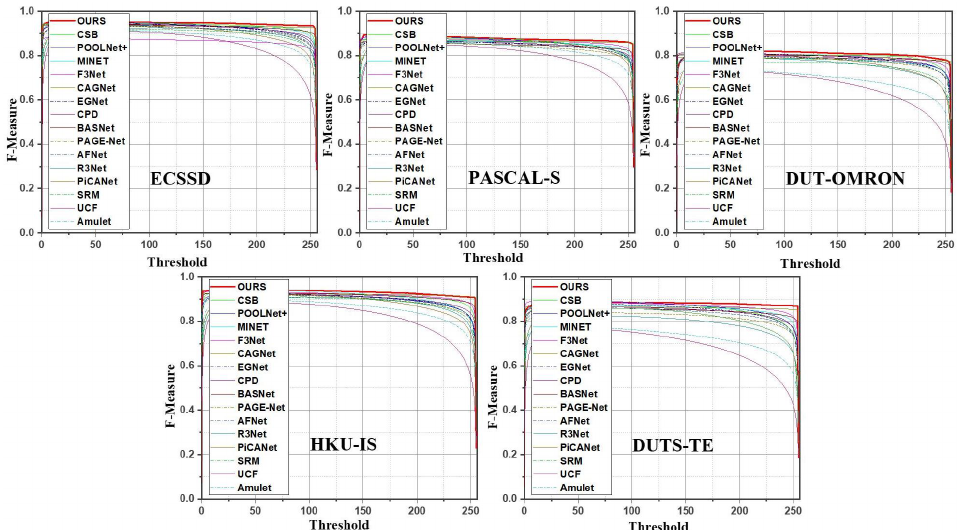
Figure 7. F-measure comparison on five different datasets.